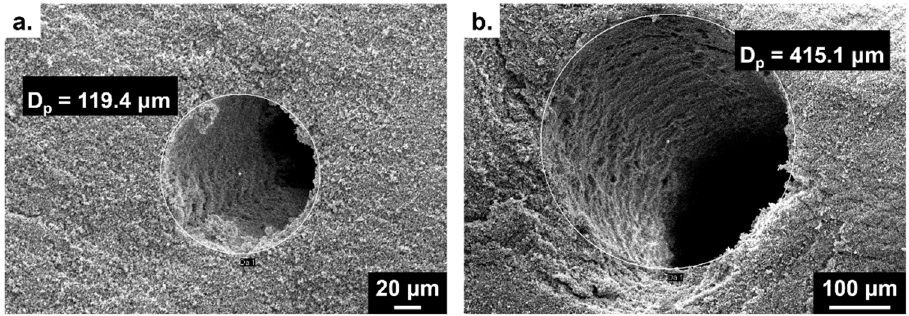
Figure 4. SEM observation of tubular pores obtained in VMA-based materials from nylon fibers with diameters of 120 µm ( a ) and 400 µm ( b ).